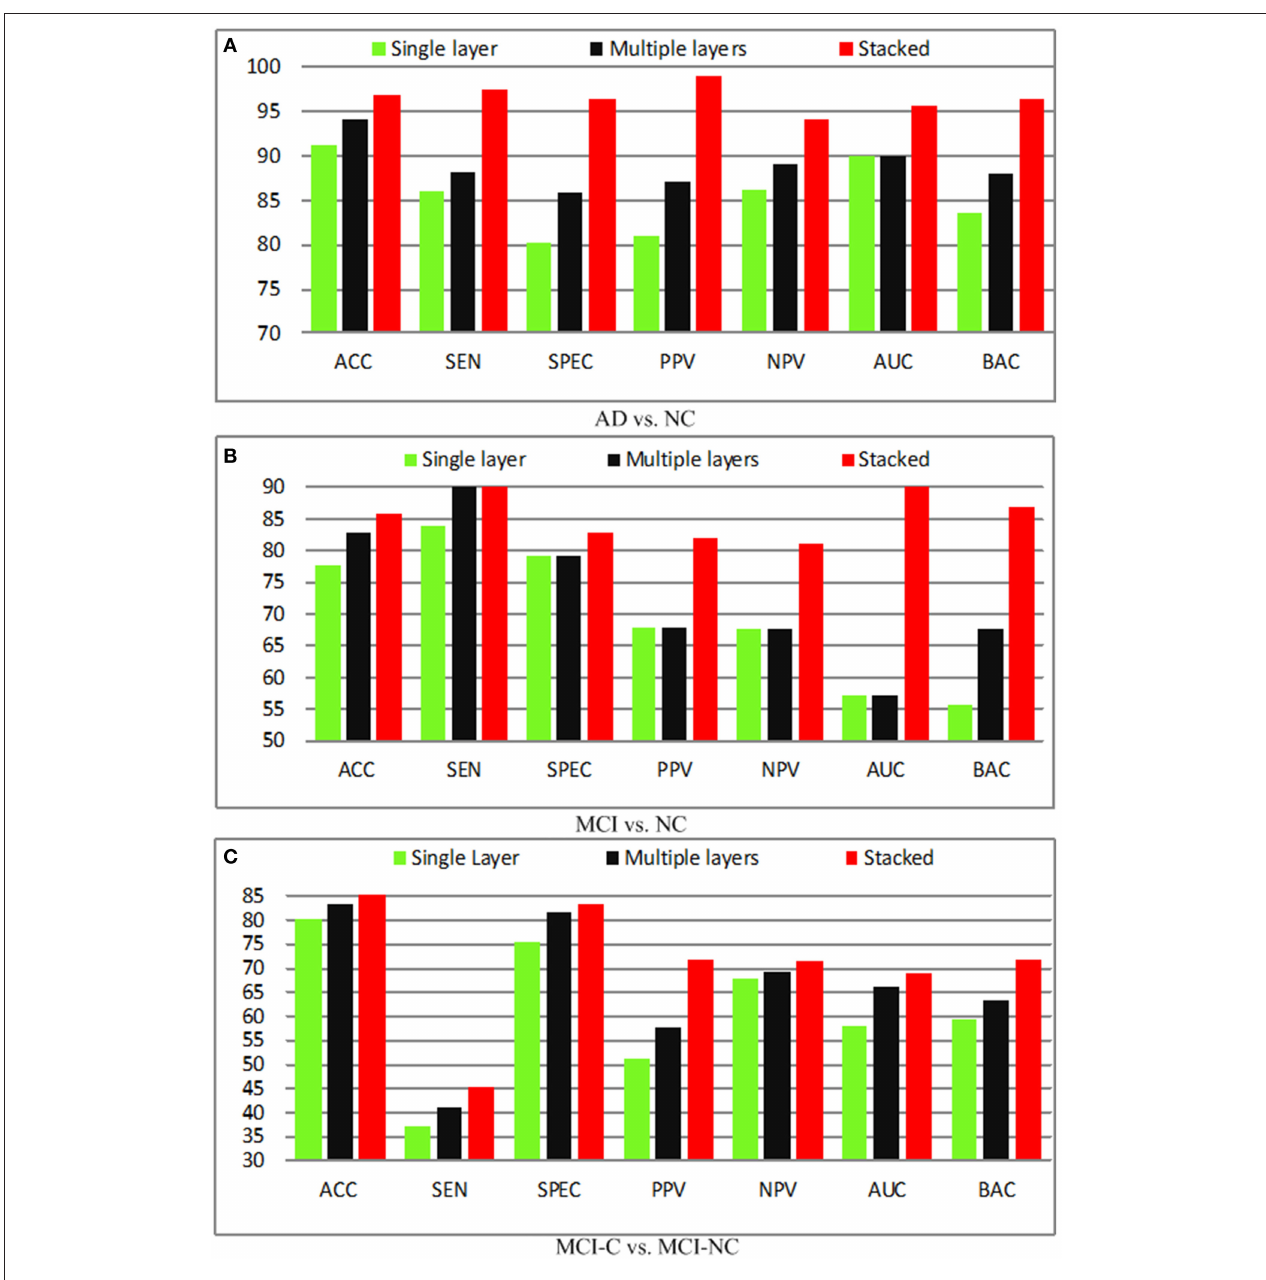
FIGURE 7 | Diagnosis results with different layers. (A) AD vs. NC; (B) MCI vs. NC; (C) MCI-C vs.